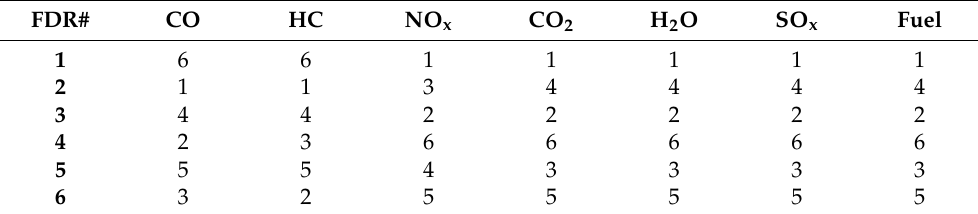
Figure 7. Emissions comparison for all the trajectories (FDR1-6). Table 3. Ordering of the flight trajectories (FDR1-6) in terms of emissions and burned fuel from 1 (the lowest) to 6 (the